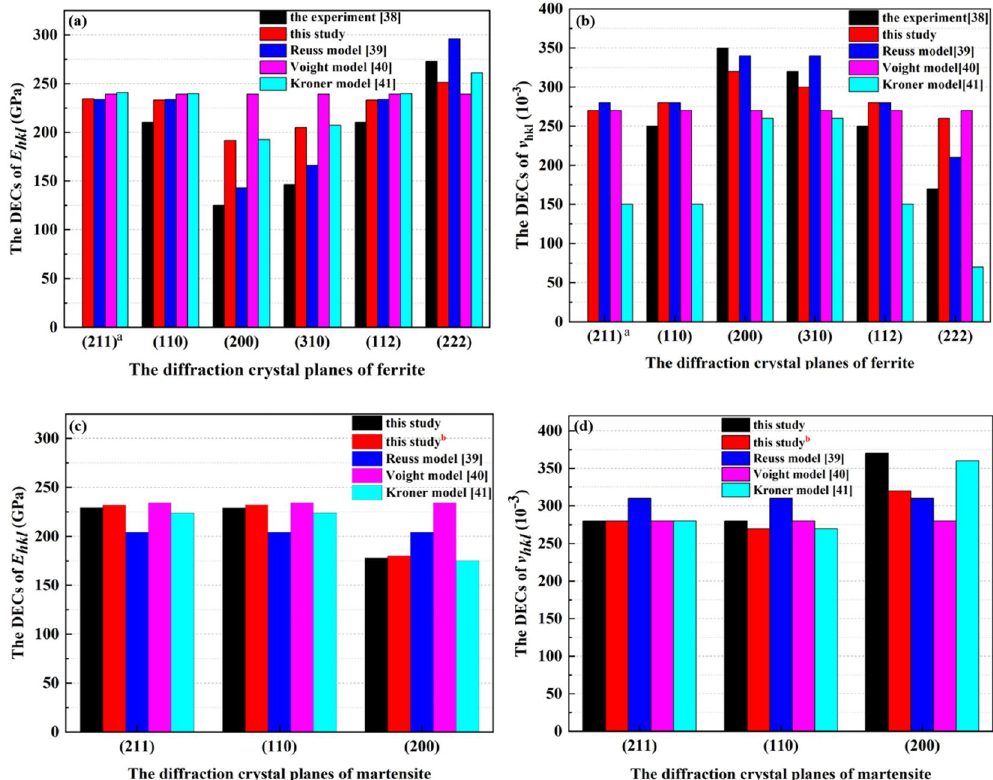
Figure 5. The DECs of constituents ( a ) E hkl of the ferrite; ( b ) v hkl of the ferrite; ( c ) E hkl of the martensite; ( d ) v hkl of the martensite.